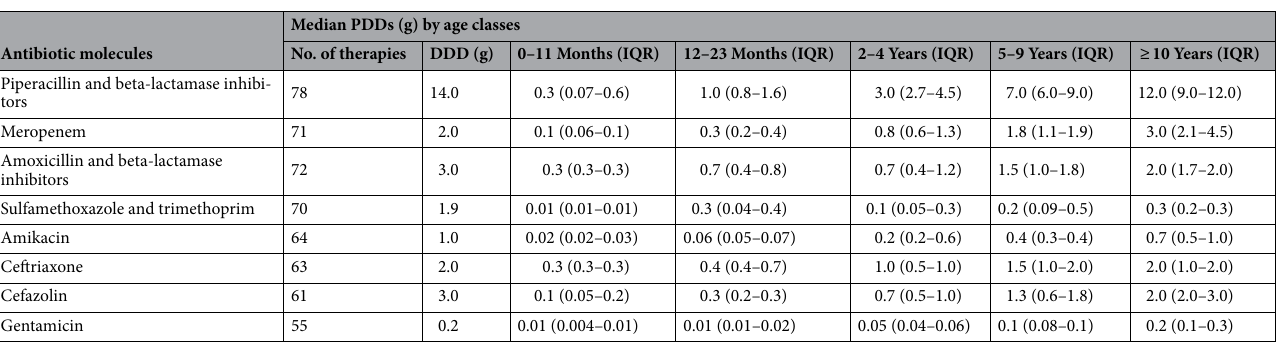
Table 3. Median PDDs of the most used antibiotic molecules provided for therapeutic purposes by age classes.